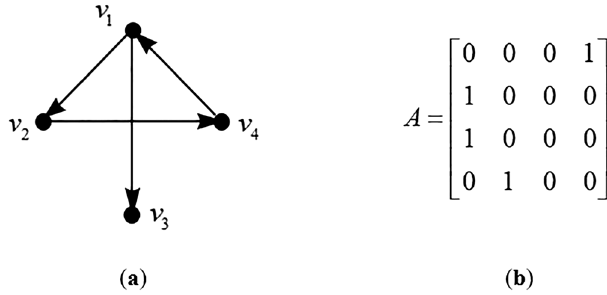
Figure 3. ( a ) A directed graph and ( b ) its adjacency matrix.